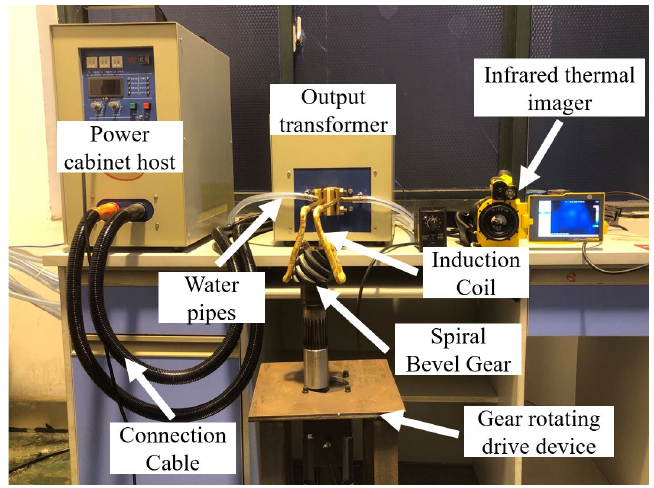
Figure 16. Electromagnetic induction heating